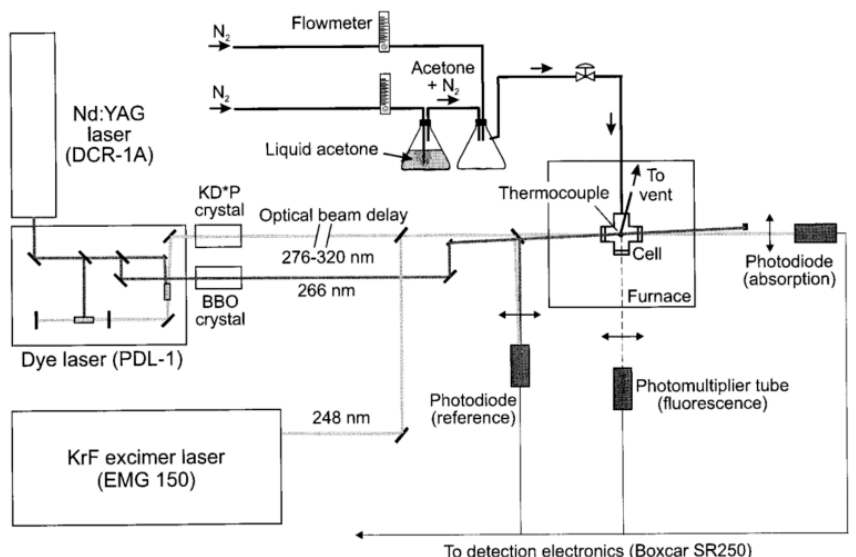
Figure 38. Experimental schematic from Thurber et al. [173] for acetone fluorescence and absorption temperature-dependence experiments. Reprinted by permission from Ref. [173], Applied Optics, Copyright © 2022 The Optical Society.